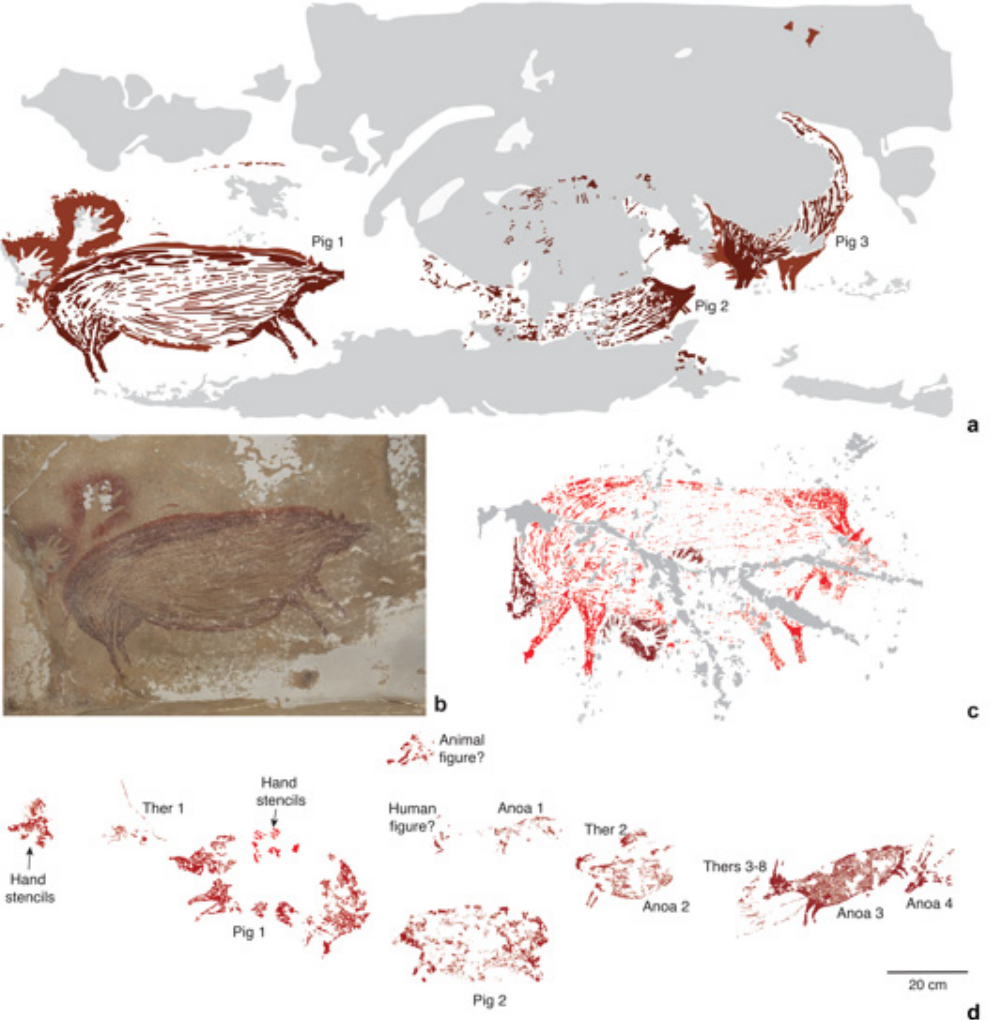
Figure 4. Dated Pleistocene rock art images of S. celebensis from caves in Sulawesi. ( a ), Digital tracing of a rock art panel from Leang Tedongnge, depicting three S. celebensis individuals (Pigs 1–3); ( b ), photograph of Pig 1, which has been dated using the U-series method to at least 45.5 ka [83]. Dimensions: Pig 1 (136 × 54 cm), Pig 2 (125 × 53 cm), Pig 3 (138 × 71 cm). ( c ), Digital tracing of a painting of a S. celebensis pig (187 cm in length and 110 cm in height) at Leang Balangajia 1, which yielded a minimum U-series age of 32 ka [83]. ( d ), Digital tracing of a rock art panel portraying a hunting ‘scene’ at Leang Bulu’ Sipong 4. U-series dating shows that this narrative composition was painted at least 43.9 ka ago [82]. It depicts small therianthrope-like figures (Thers 1–8) using spears or ropes to hunt S. celebensis pigs (Pigs 1–2) and dwarf bovids (Anoas 1–4) [82]. Grey shaded areas in ( a , c ) represent exfoliated portions of rock art panels. Credits: ( a , c , d ): A.A. Oktaviana; ( b ), M.